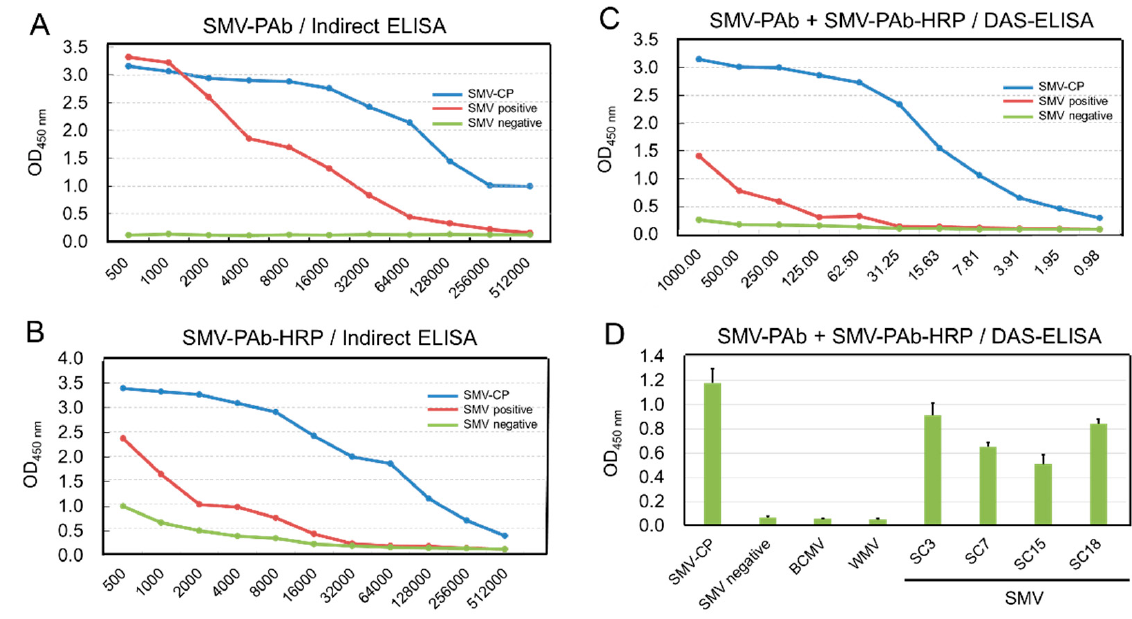
Figure 4. Development and characterization of SMV-CP-specific PAb. ( A ) The titer of PAb-SMV-CP against SMV-CP recombinant protein determined by indirect ELISA; ( B ) The titer of PAb-SMV-CP-HRP detected by indirect ELISA; ( C ) The DAS-ELISA of SMV-CP protein by DAS-ELISA; ( D ) Specificity tests of the DAS-ELISA for SMV detection.